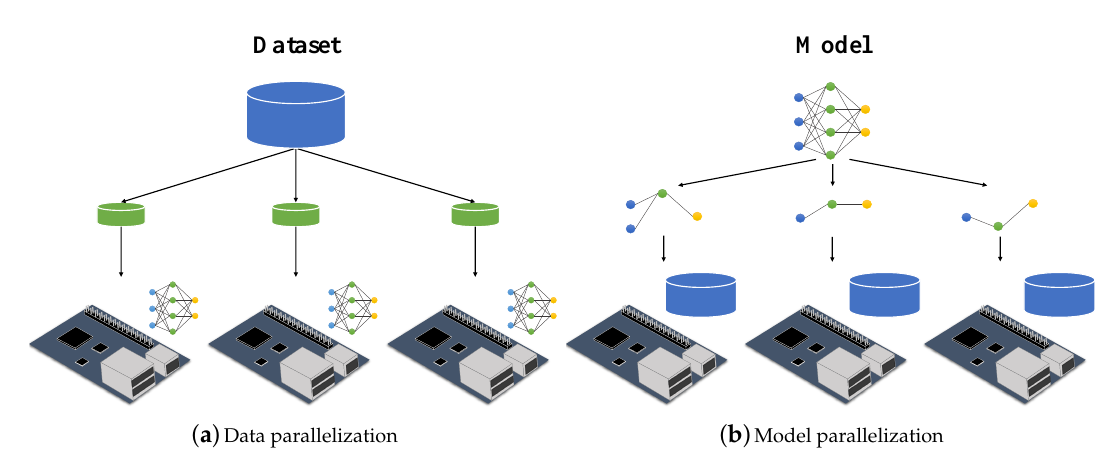
Figure 1. Parallelization method of distributed